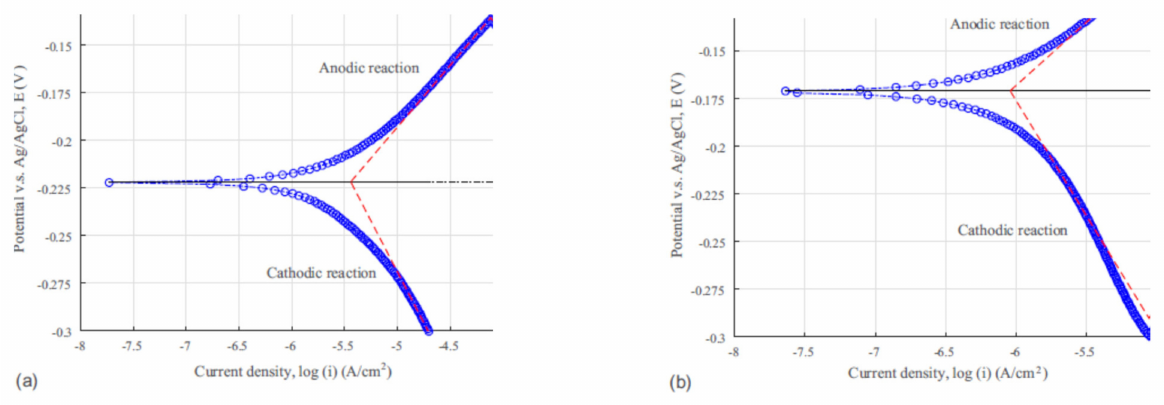
Figure 6. Corrosion tests results for uncoated brass specimen ( a ) and coated brass specimen ( b ).